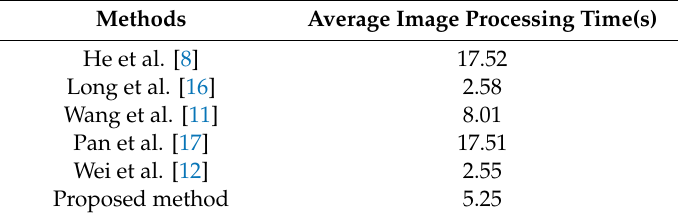
Table 5. Comparison results of the average image processing time using various methods.